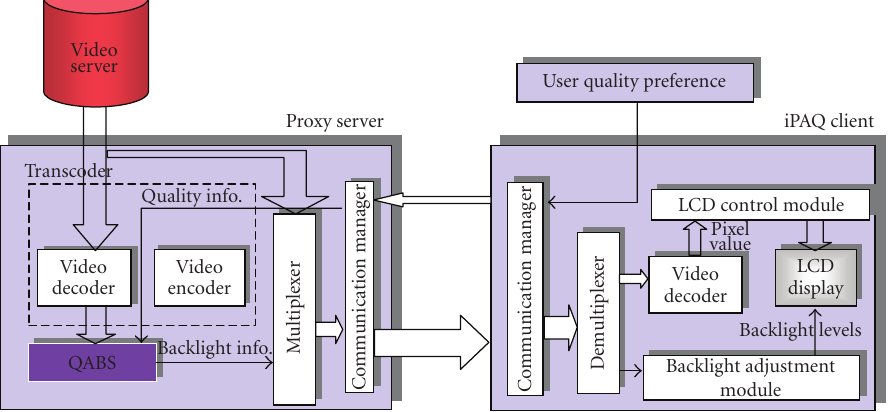
Figure 8: Prototype implementation.